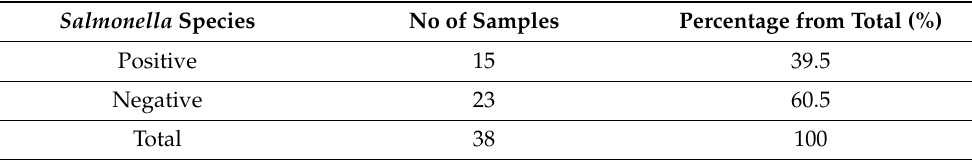
Table 2. Distribution of Salmonella species in the studied